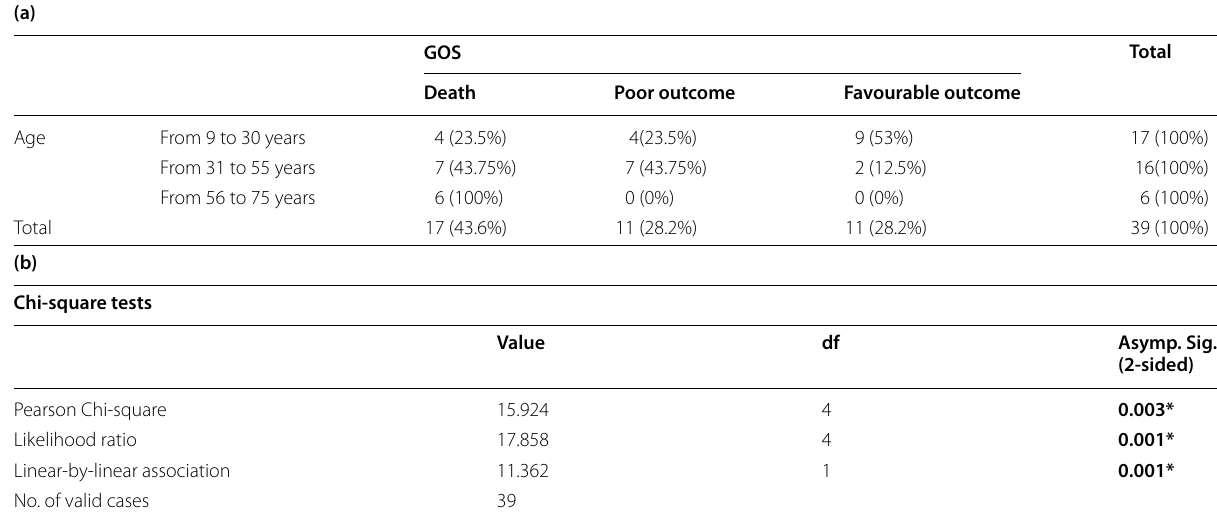
Table 1 Glasgow Outcome Score (GOS) in relation to age